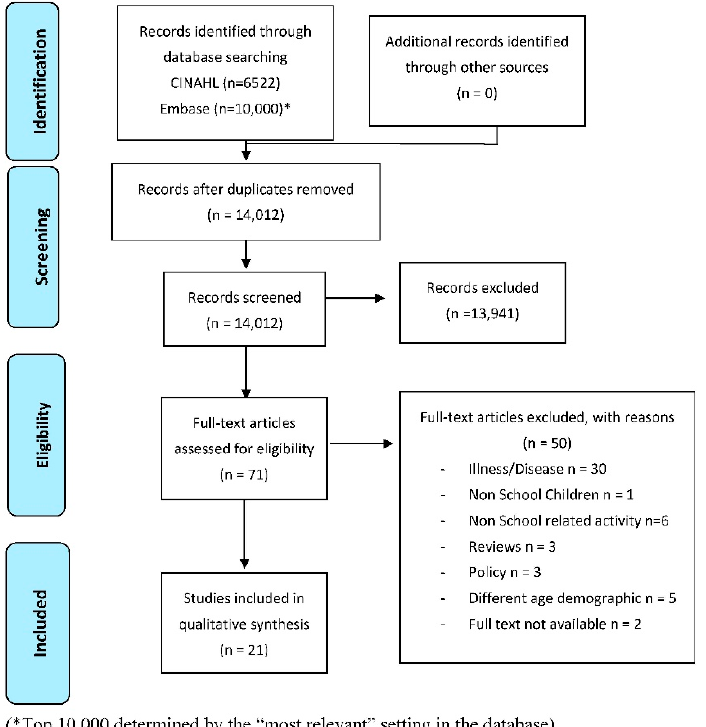
Figure 1. Preferred reporting items for systematic reviews and meta-analyses (PRISMA) diagram [31] detailing results of the search, screening and selection processes.